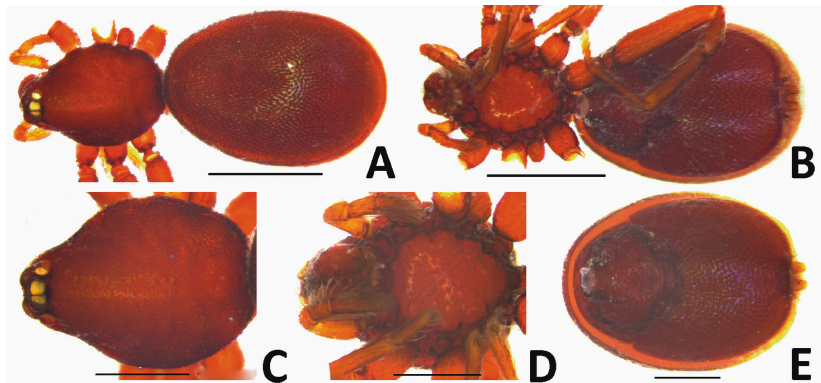
Figure 4. Grymeus dharmapriyai n. sp., female from Wanathavilluwa: A , habitus, dorsal view; B , same, ventral view; C , carapace, dorsal view; D , sternum, ventral view; E , abdomen, ventral view. Scale bars: 1 mm ( A–B ), 0.5 mm ( C–E ).